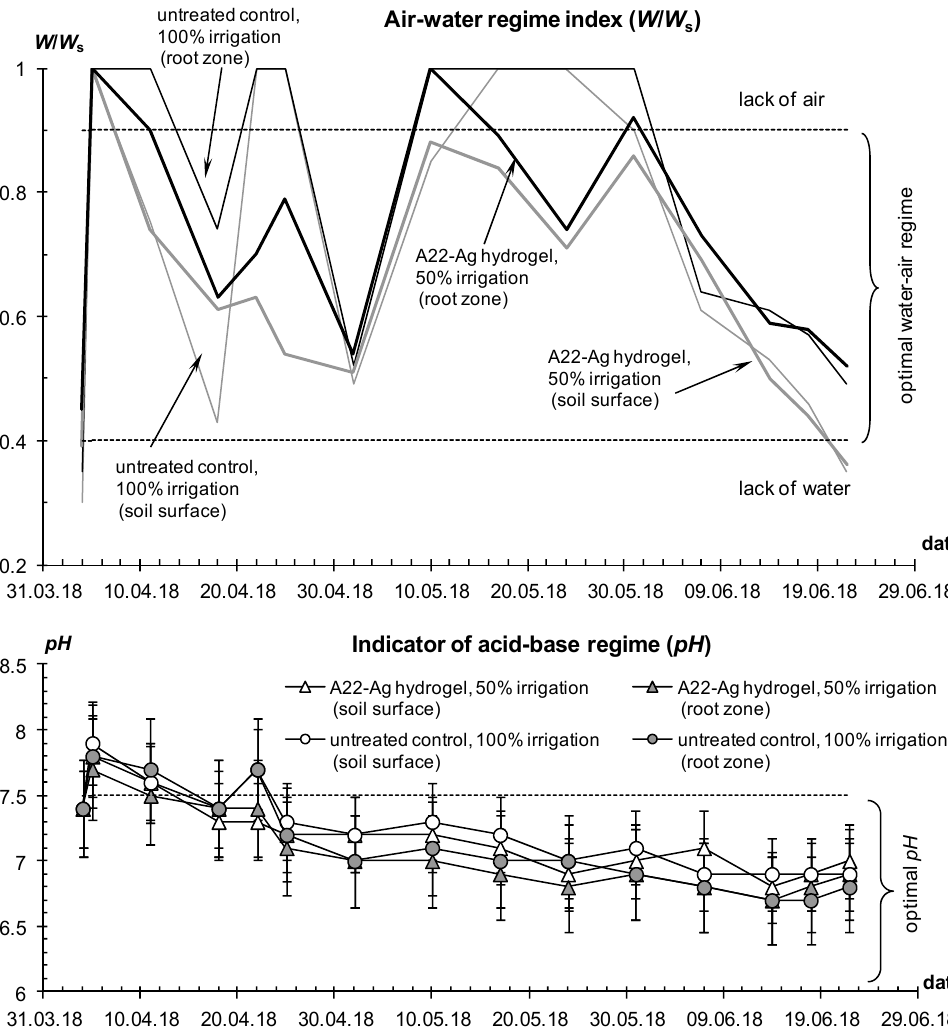
Figure 9. Soil regimes under the influence of irrigation and gel-forming conditioners (Uzbekistan, Serozem, furrow irrigation, 2018).